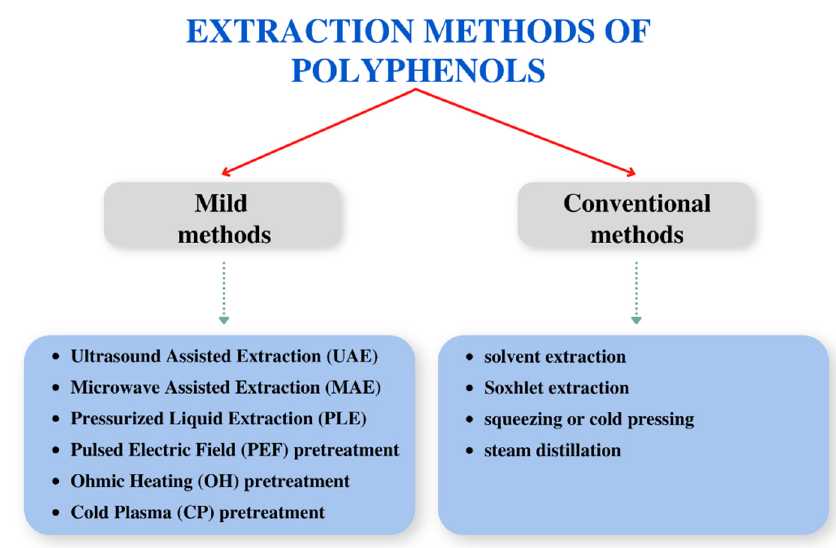
Figure 2. Classification of polyphenols’ extraction methods.